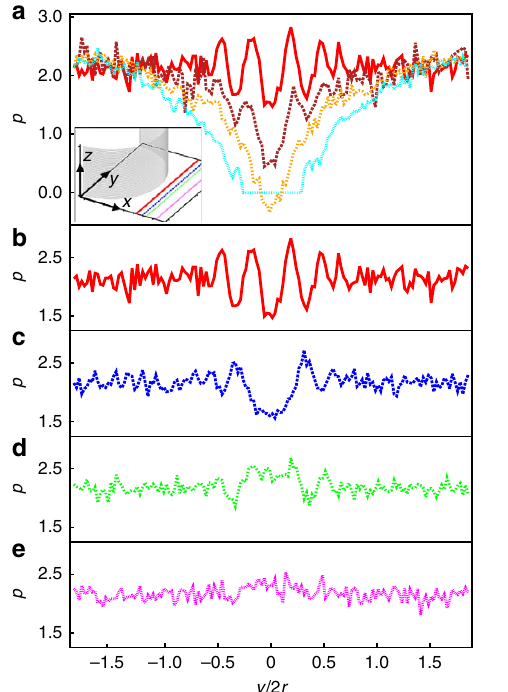
Figure 4 | Mapping the local pressure. ( a ) Dependence of the local pressure at distance 0.7 behind the surface of the cylindrical pillar in the direction of flow, plotted across the channel width ( y -axis) for Er C 65 (red line), Er C 583 (brown dashed line), Er C 786 (orange dashed line) and Er C 897 (cyan dotted line). The inset in ( a ) shows a sketch of different positions behind the cylindrical pillar at which the local pressure was measured. ( b – e ) Plots of local pressure at specific distances behind the surface of the cylindrical pillar for Er C 65: ( b ) at a distance of 0.7 behind the pillar, ( c ) at 1.3, ( d ) at 1.7 and ( e ) at 2.7. y -axis. If the local pressure is calculated further away from the